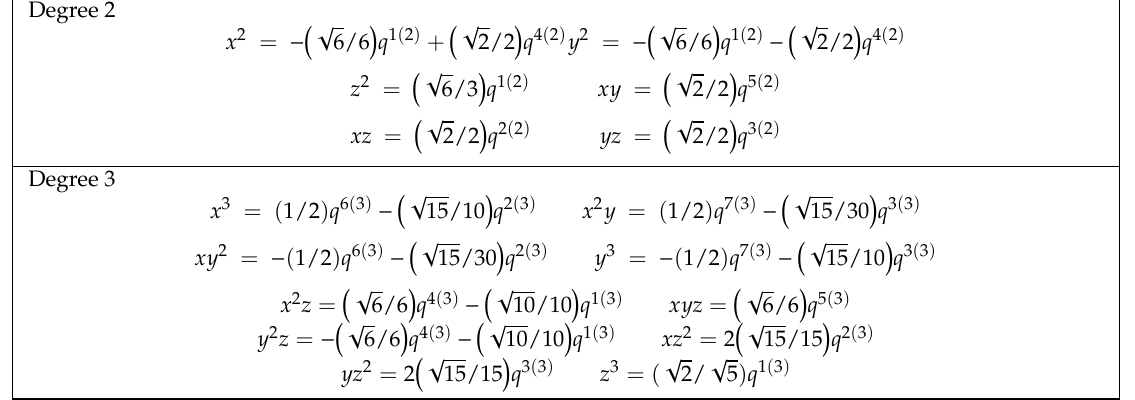
Table 2. Cartesians in terms of spherical harmonics, up to rank 3. Adapted from Stone, such that the transformation is the inverse of Table